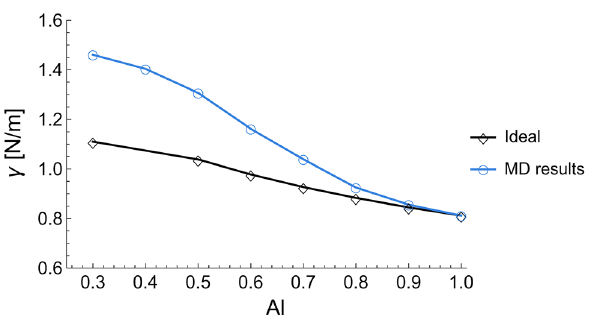
Figure 9. Surface tension of Al–Ni alloys as obtained using MD and using the ideal solution model.